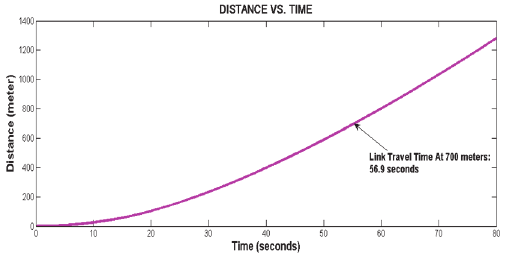
Fig 7. Distance versus time